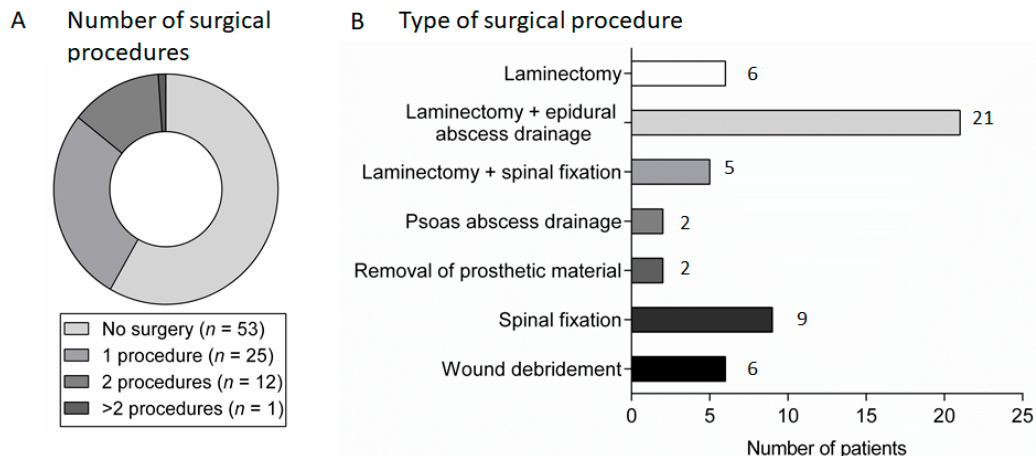
Figure 3. Surgical management in patients with spondylodiscitis: ( A ) the number of surgical procedures carried out in patients with spondylodiscitis; and ( B ) the frequency of different types of surgical procedures carried out in patients with spondylodiscitis.